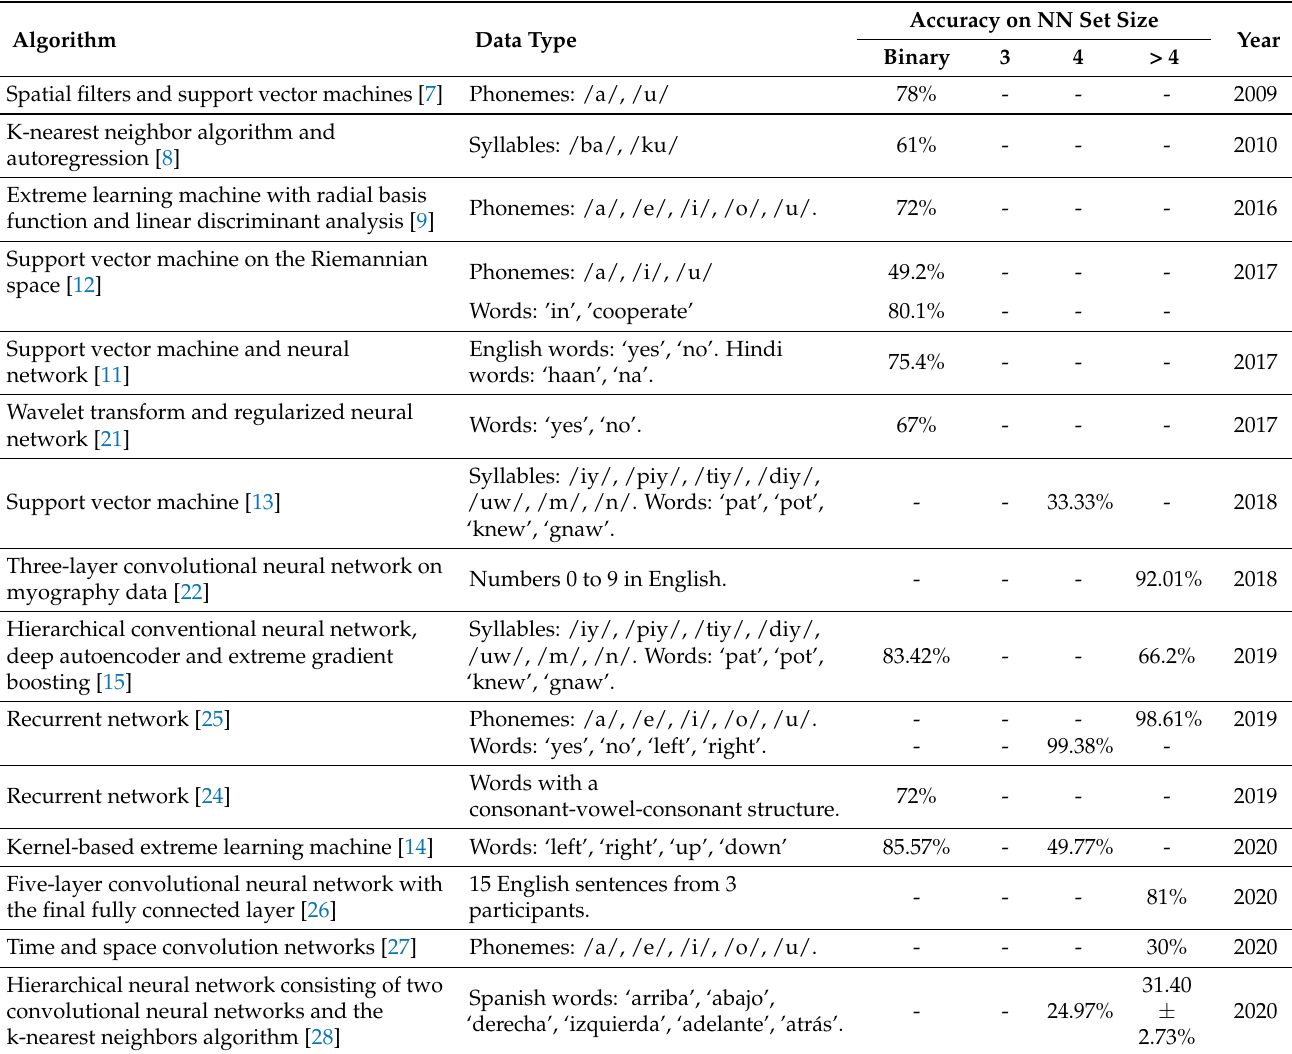
Table 1. Comparison of existing works focused on silent speech recognition using biological electrical activity.